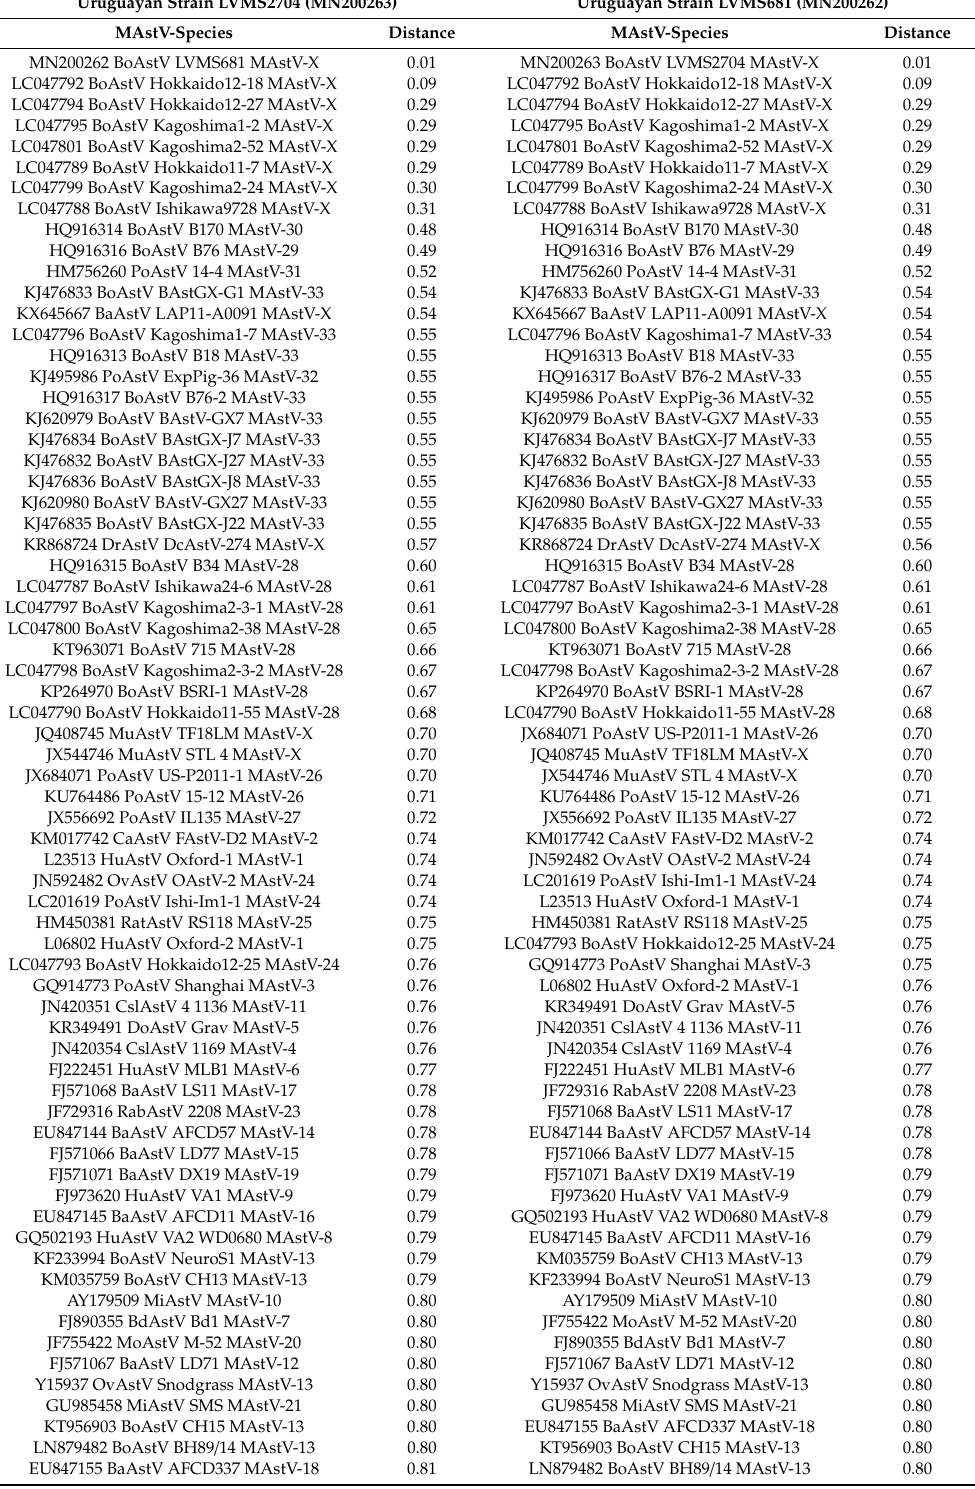
Table 2. Estimates of evolutionary divergence between sequences at the amino acid level. The number of amino acid di ff erences per site between sequences are shown (p-distance), on the left side the reference is the Uruguayan strain LVMS2704 (MN200263), and on the right side the reference is the Uruguayan strain LVMS681 (MN200262). Complete capsid sequences were used. Sequence names are: Accession number Host Strain name